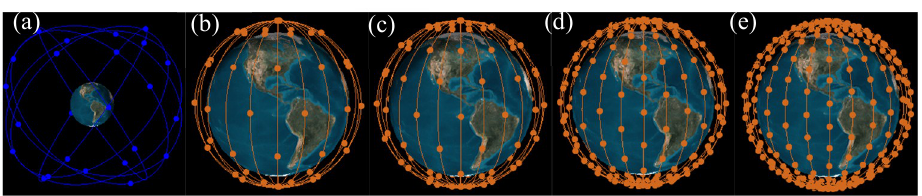
Figure 1. GPS and LEO constellations. ( a ) GPS; ( b ) 60 LEO; ( c ) 96 LEO; ( d ) 192 LEO; ( e ) 288 LEO.